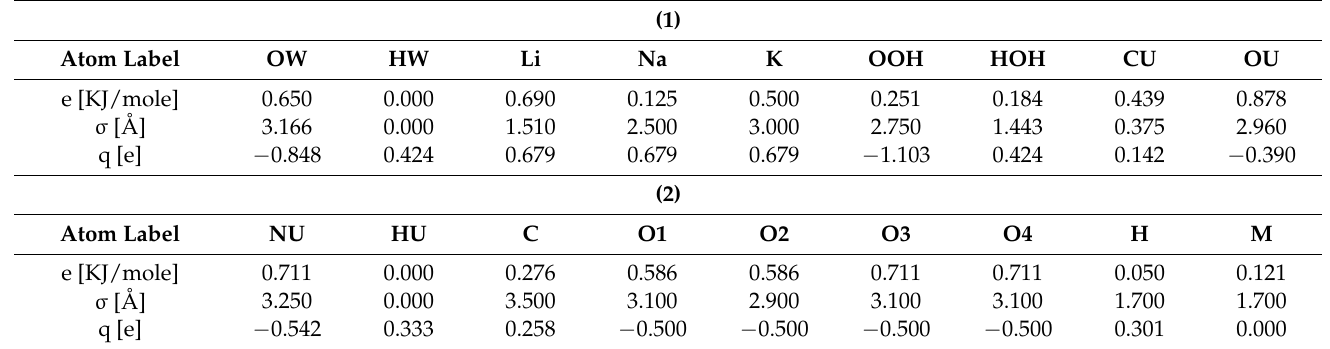
Table 3. Cubic simulation box atomic number density and number of molecules used in EPSR. Sample Labels Li(K)OH Urea Trehalose